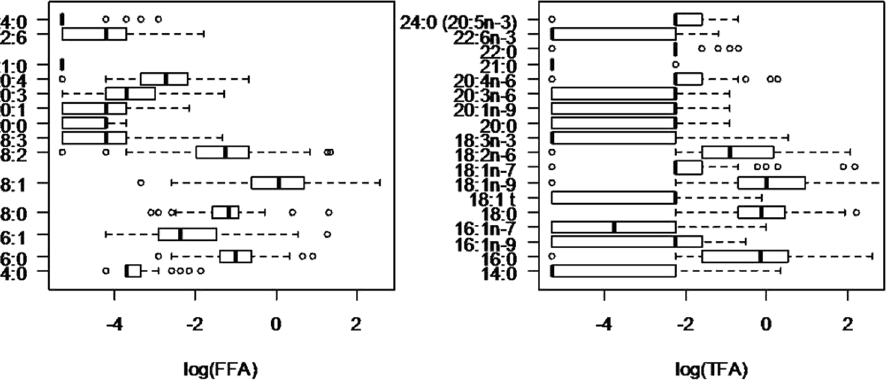
Figure 2. Box plot representations (n = 54) of Free fatty acids (FFA) on the left, and Total fatty acids (TFA) on the right. Logarithmic transformations were applied to all variables. Box outline represents the lower quartile and upper quartiles, the bold vertical line is the median value and outermost points correspond to observations that are far from the box (at a distance higher than 1.5 times the interquartile range).